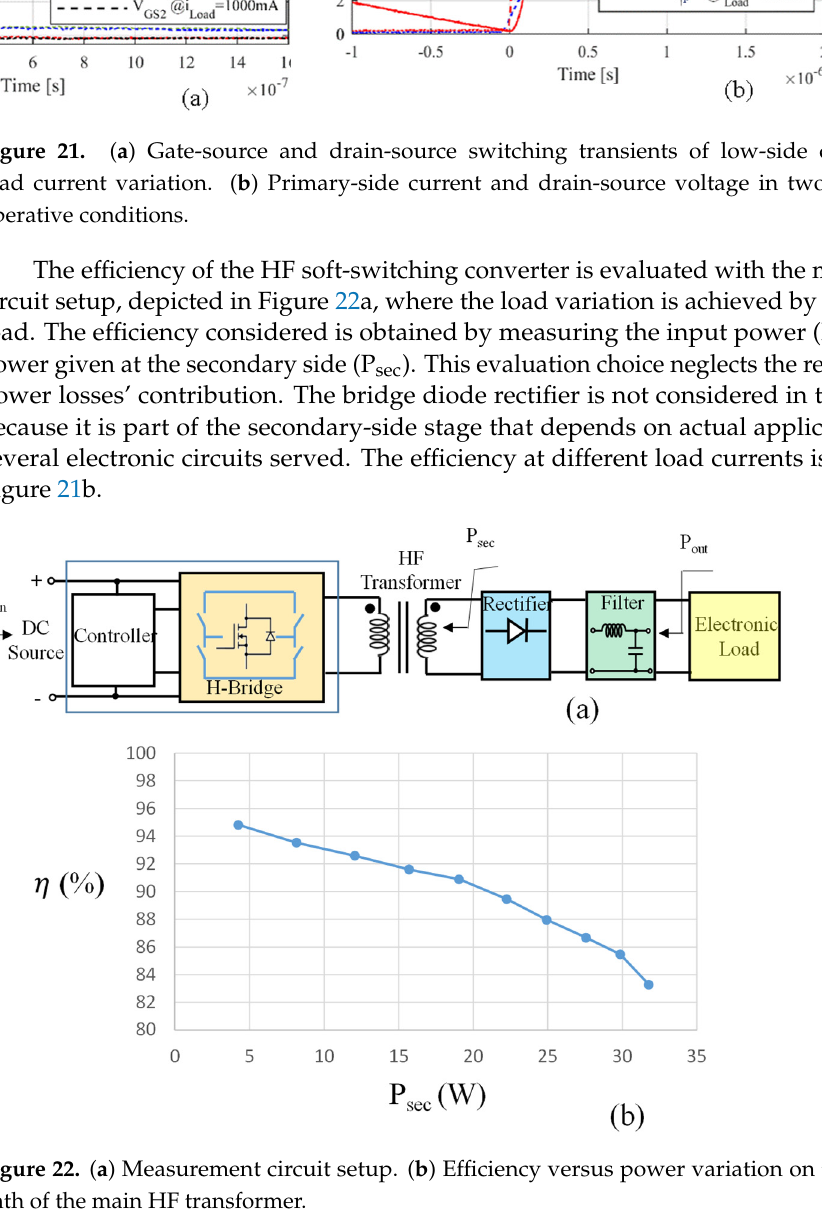
Figure 22. ( a ) Measurement circuit setup. ( b ) Efficiency versus power variation on the secondary path of the main HF transformer.